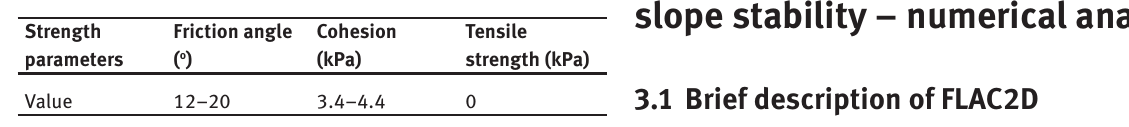
Table 2: Strength parameters of the fault in the studied region [33].